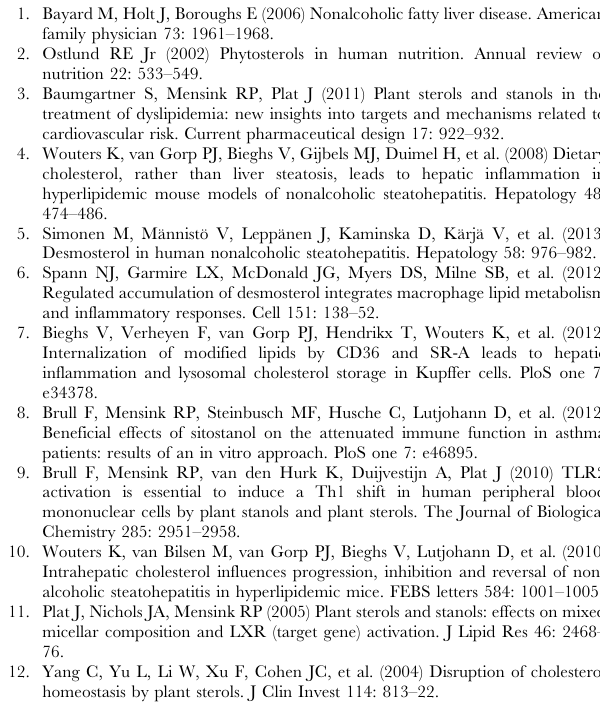
Figure S1 Hepatic gene expression. (A–D) Gene expression analysis of enzymes involved in cholesterol biosynthetic pathway Cyp51 , LSS , Dhcr24 and Dhcr7 . Relative expression was normalized to endogenous control gene Cyclophilin A. Data were set relative to group on chow diet. n= 10 per group. *P , 0.05 and **P , 0.01,